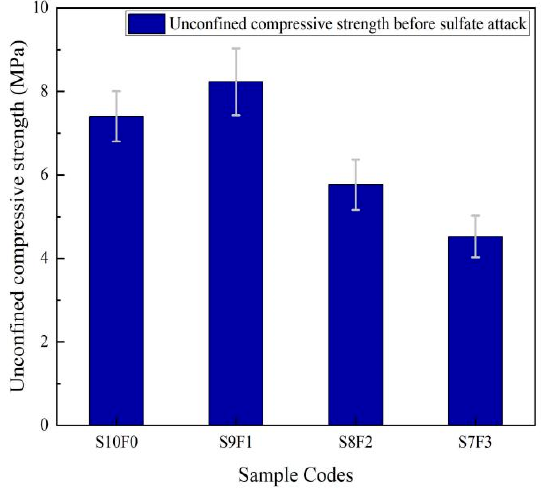
Figure 4. The UCS of SF-GSSS before sulfate a tt ack.